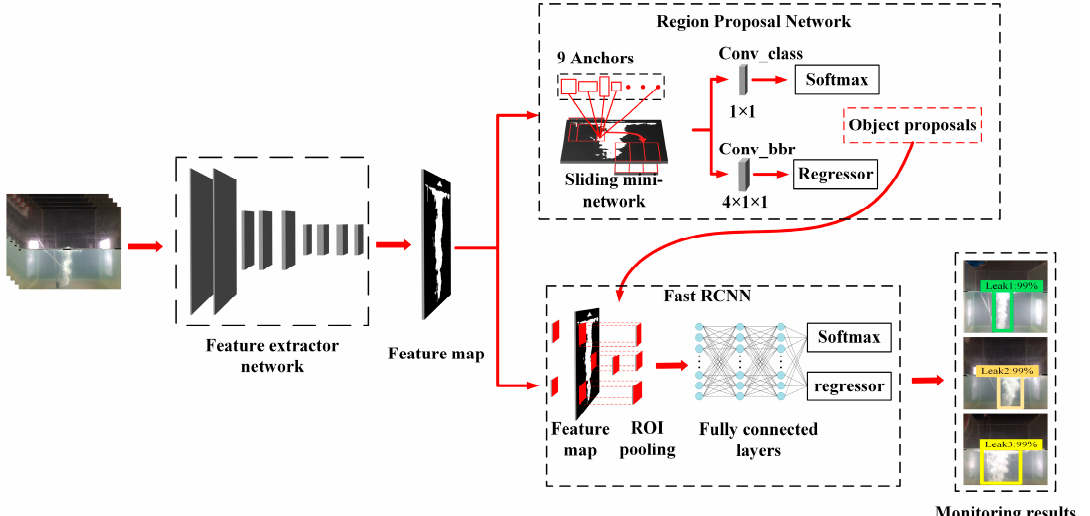
Figure 1. The detection architecture of the Faster R-CNN approaches.